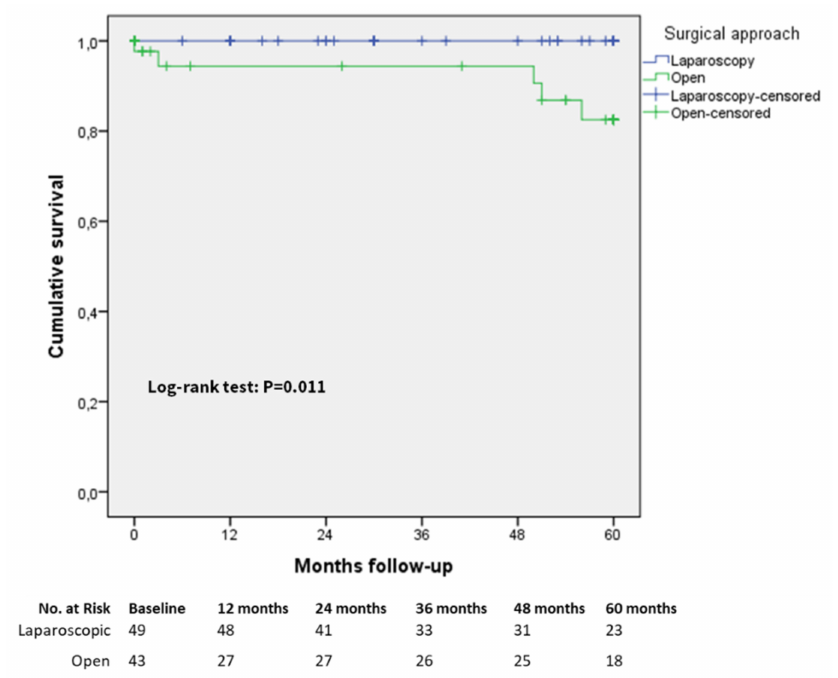
Figure 4. Five-year overall survival matched cohort in stage IB patients. As indicated in Table 5, the univariate analysis showed that the age, gender, geographic area, year of surgery, BMI, ASA score, operative time, type of surgical approach, length of hospital stay, type of resection, tumor location, number of harvested lymph nodes, margin status, TNM stage, number of metastatic lymph nodes, and histology were